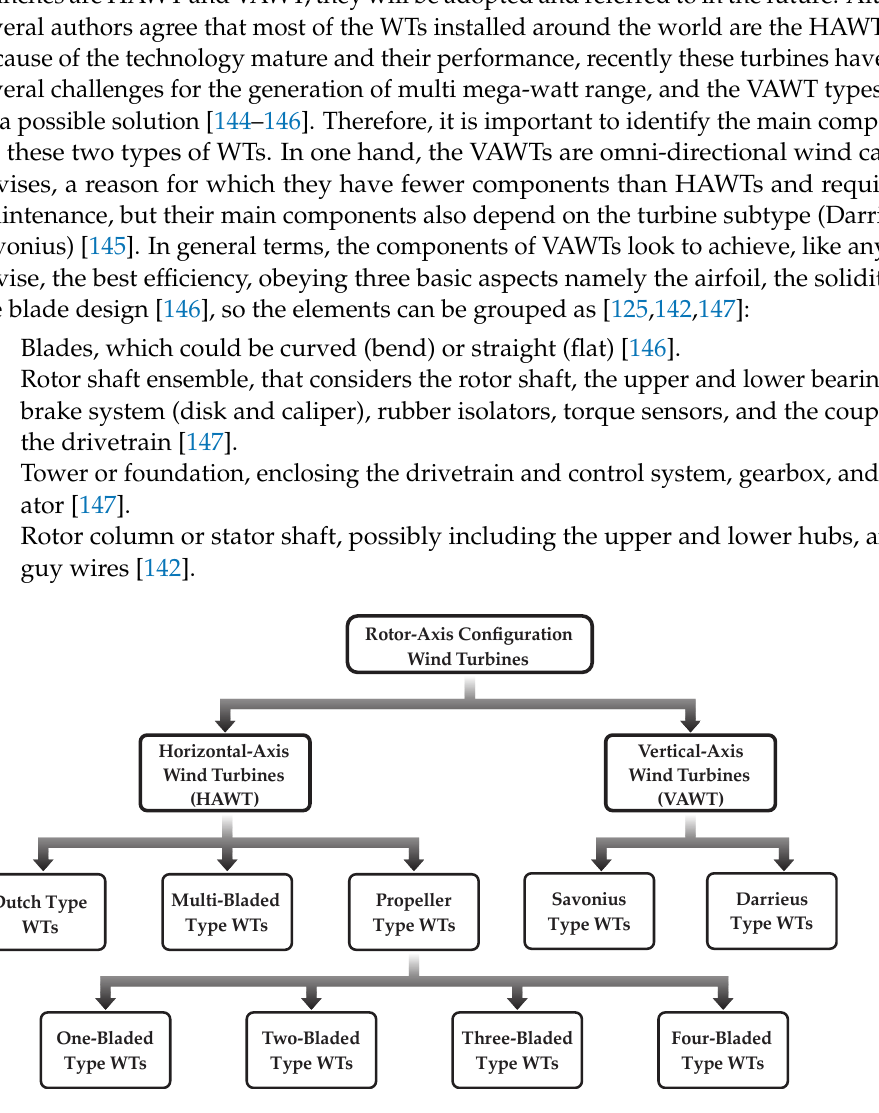
Figure 5. Classification of WTs according to the rotation-axis like HAWTs and VAWTs type (adapted with permission from Ref. [142] Copyright 2021, Bhattacharjee, S).